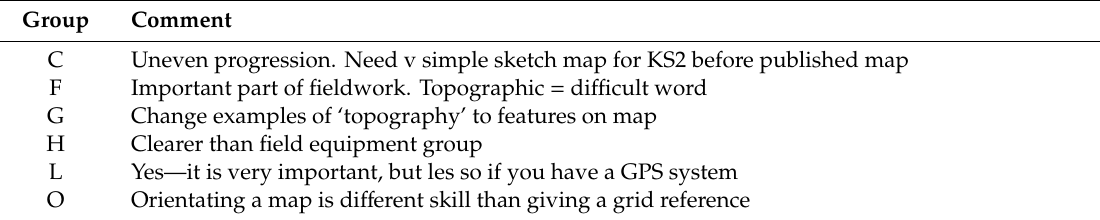
Table A5. Use a topographic map e ff